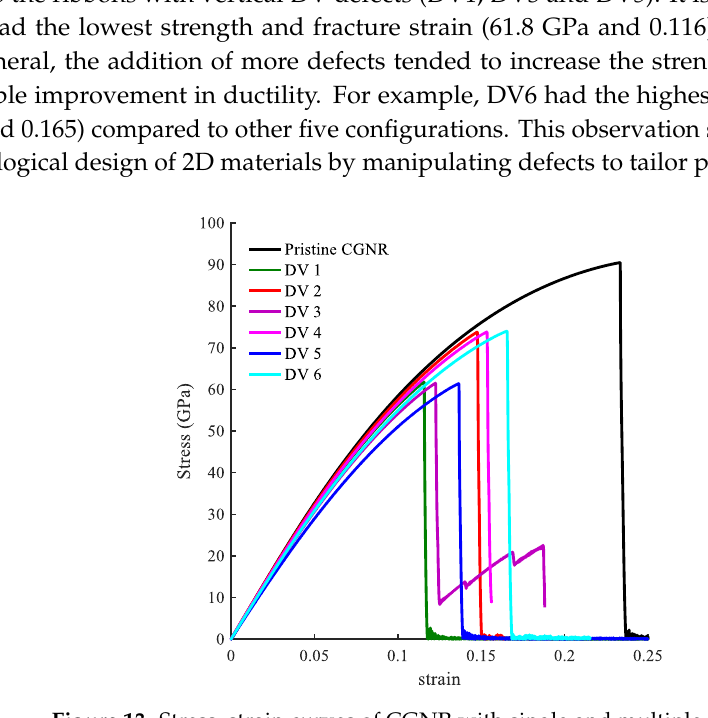
Figure 12. Geometry of CGNR with single and multiple DV defects.